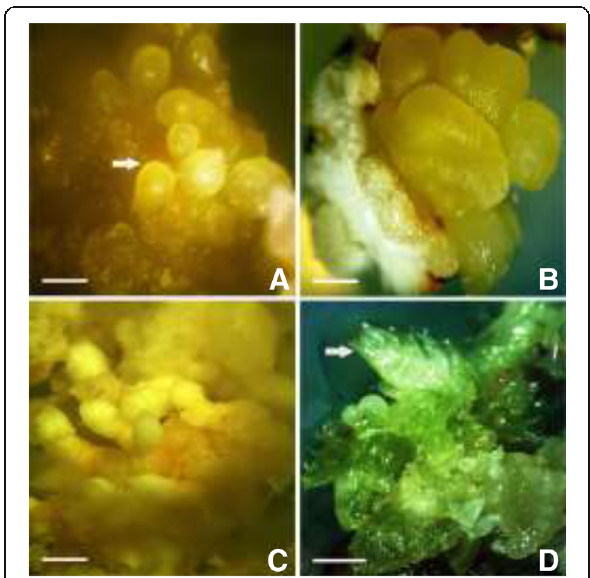
Fig. 1 Induction of somatic embryogenesis in Asparagus racemosus from zygotic embryos. a Initiation of globular embryos (arrow marked) from embryogenic callus on CIM (bar 0.09 mm). b Globular embryo differentiation after 30 days of transfer to SEI medium. Note the smooth shining surface of the globular embryos (bar 0.05 mm). c Bipolar embryo structures developing from globular embryos 30 days after subculture to fresh SEI medium (bar 0.15 mm). d Germinating multiple somatic embryos (arrow marked) 14 days after transfer to SEG medium (bar 0.135 mm)